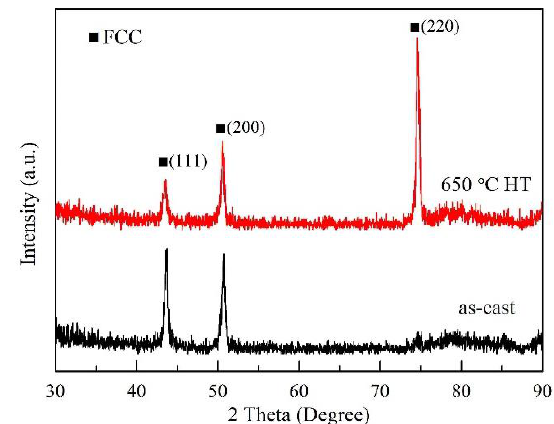
Figure 7. The XRD pattern of as cast and heat treated (HT) Al 0.25 CoCrFeNi high-entropy alloy. The heat treatment procedure is firstly heated to 650 °C at the heating rate of 10 K/min, holding for 1 min and quenched in water.